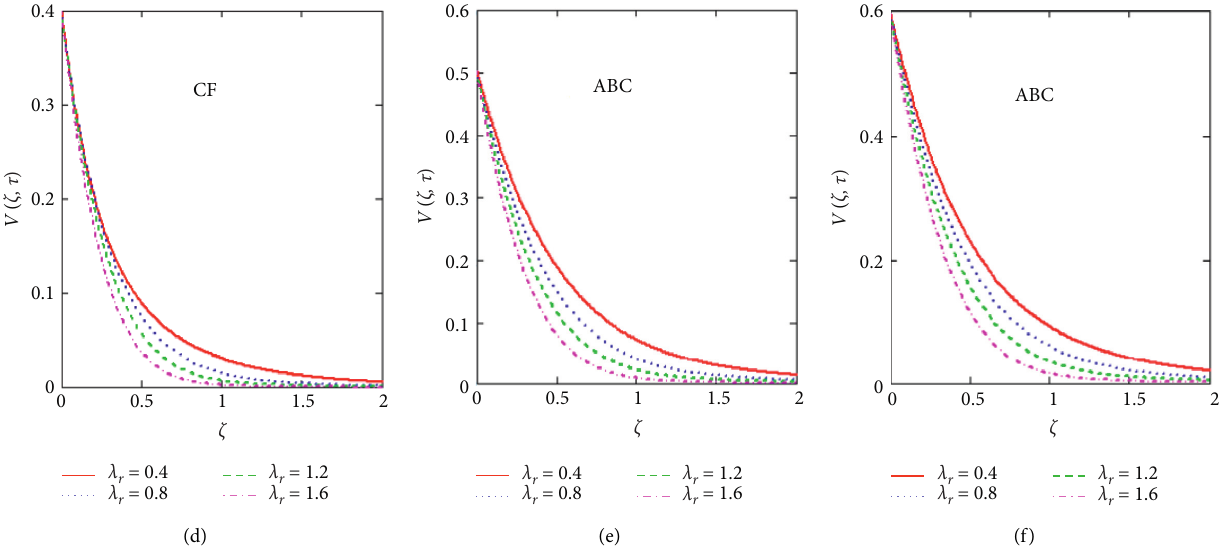
Figure 7: Plot via C, CF, and AB approaches for velocity with different values of λ